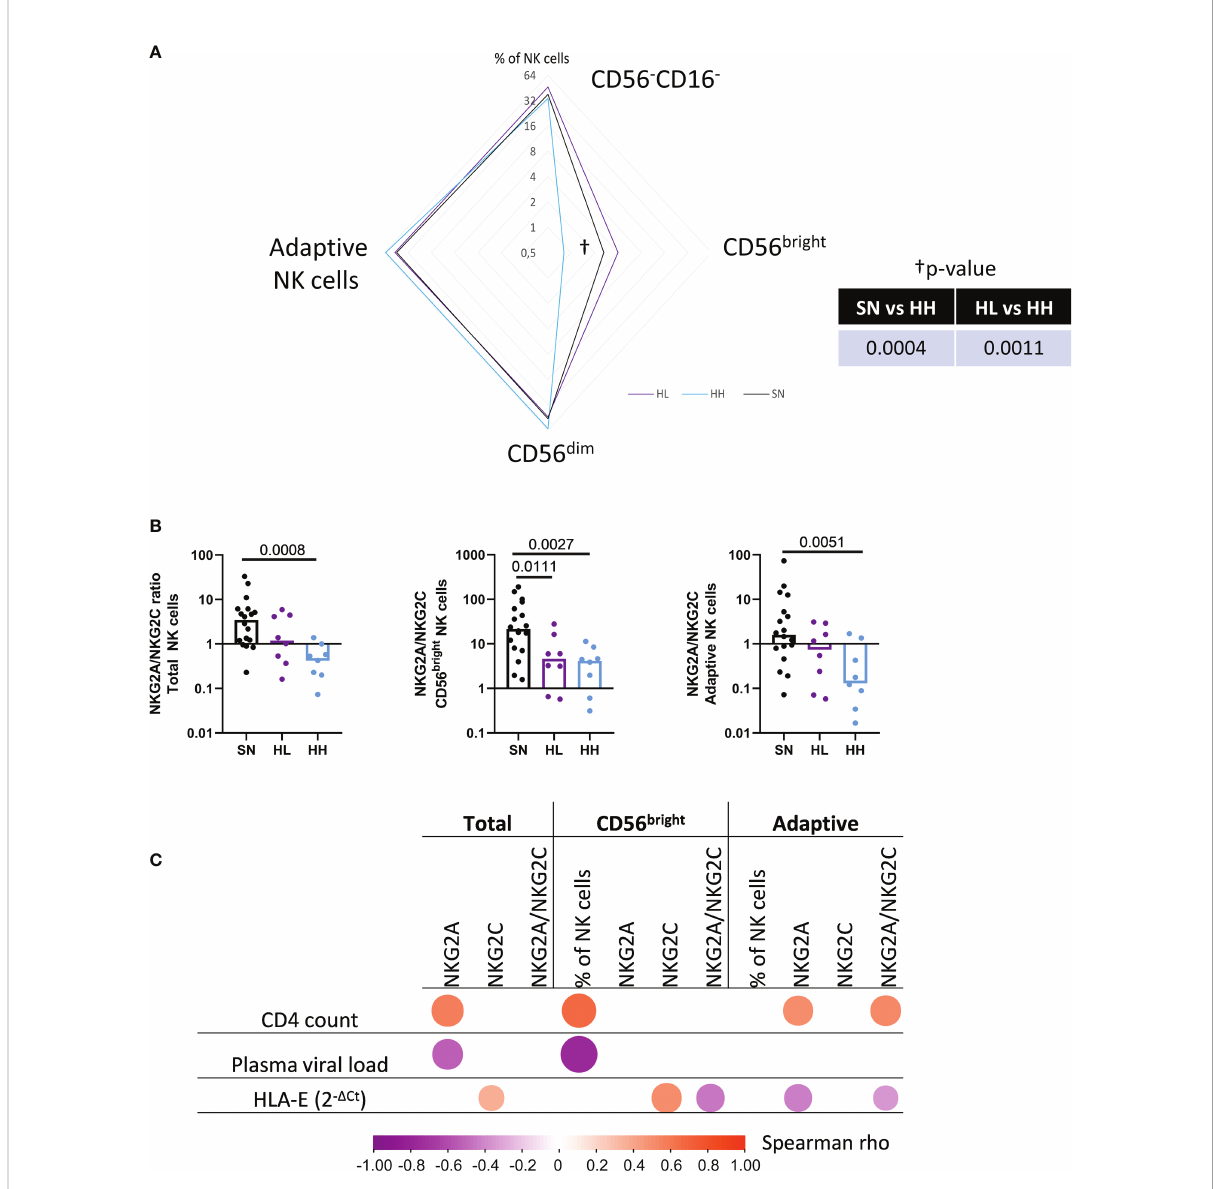
FIGURE 3 Manual gating analysis of the NK cell fraction. (A) Magnetically sorted NK cells from HIV seronegative (SN, n=18), HIV-low (HL, n=8) and HIV- high (HH, n=8) were characterized by manual gating. Four different subpopulations were characterized as CD56 - CD16 - , CD56 bright (CD56 bright + CD16 - ), CD56 dim (CD56 dim CD16 + ) and adaptive NK cells (CD56 dim CD16 + CD57 + ). Differences between groups (SN, HL, HH) were analyzed by non-parametric Mann-Whitney test and represented in the radar chart. (B) NKG2A/NKG2C expression ratio in total NK cell fraction (left), CD56 bright (middle) and adaptive NK cells (right) in the different groups (SN-black, HL-purple, HH-blue). (C) Correlogram showing Spearman ’ s rank test correlation of NKG2A and NKG2C expression in total NK cells, CD56 bright and adaptive NK cells with clinical parameters (CD4 count, plasma viral load) and HLA-E mRNA expression. Only signi fi cant correlations are shown. Results were considered statistically signi fi cant when p- value